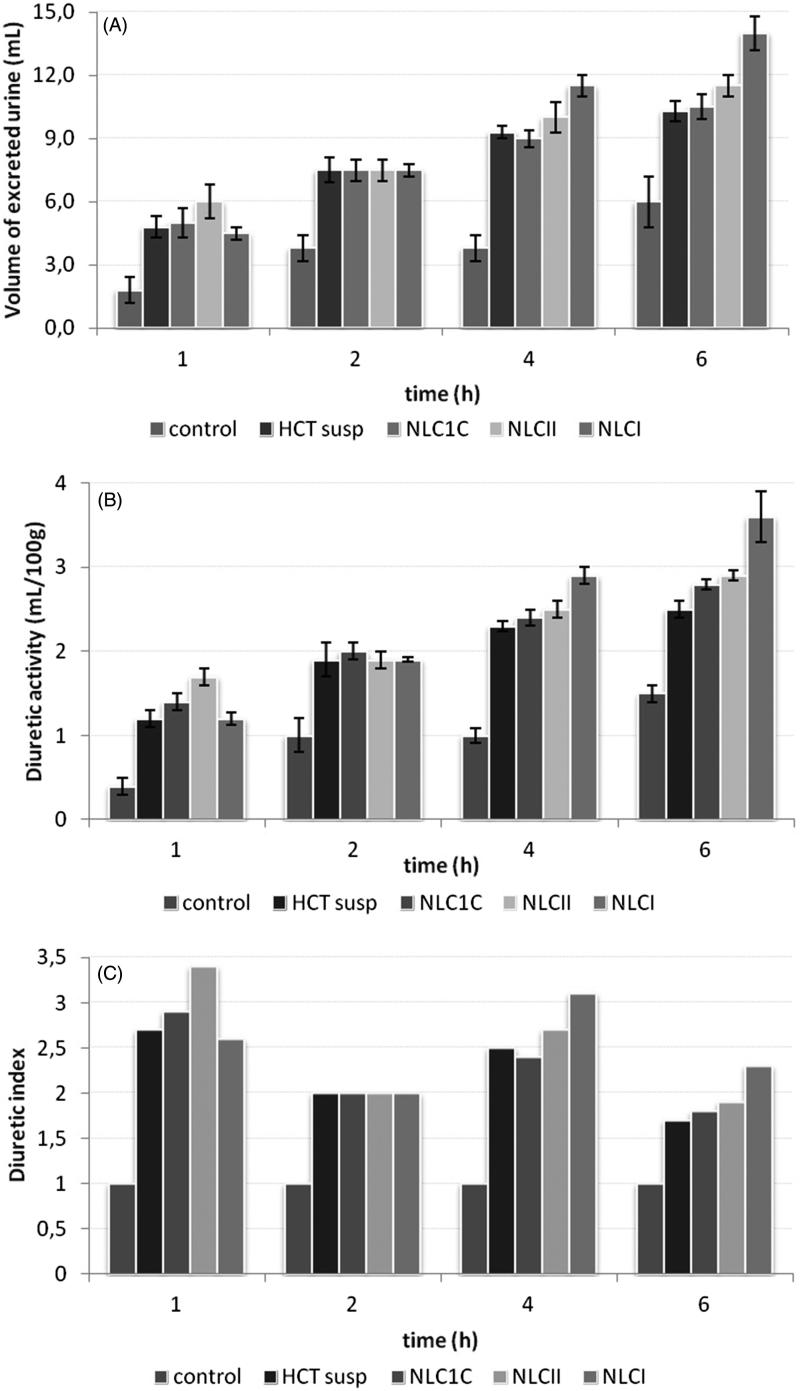
Diuretic effect expressed in terms of: volume of excreted urine (mL) (A); diuretic activity (ml/100g body weight) (B) and diuretic index (C) after oral administration (drug dose of 10 mg kg−1) of the selected HCT-loaded NLCI, NLCII and NLC1C formulations.